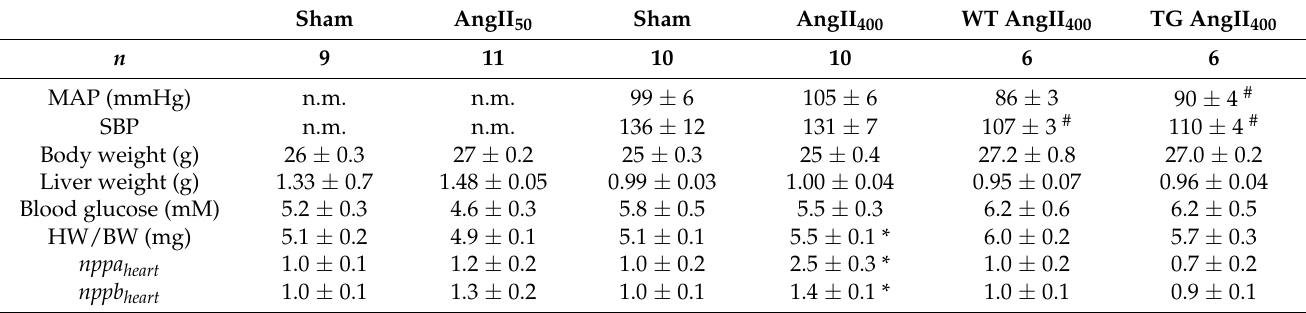
Table 1. Animal characteristics of C57BL/6J, wild-type (WT), and csNOX2 transgenic (TG) mice treated for two weeks with micro-osmotic pumps containing either saline (sham), 50 or 400 ng/kg/min angiotensin II (AngII 50 and AngII 400 ). The data are presented as mean ± SEM.